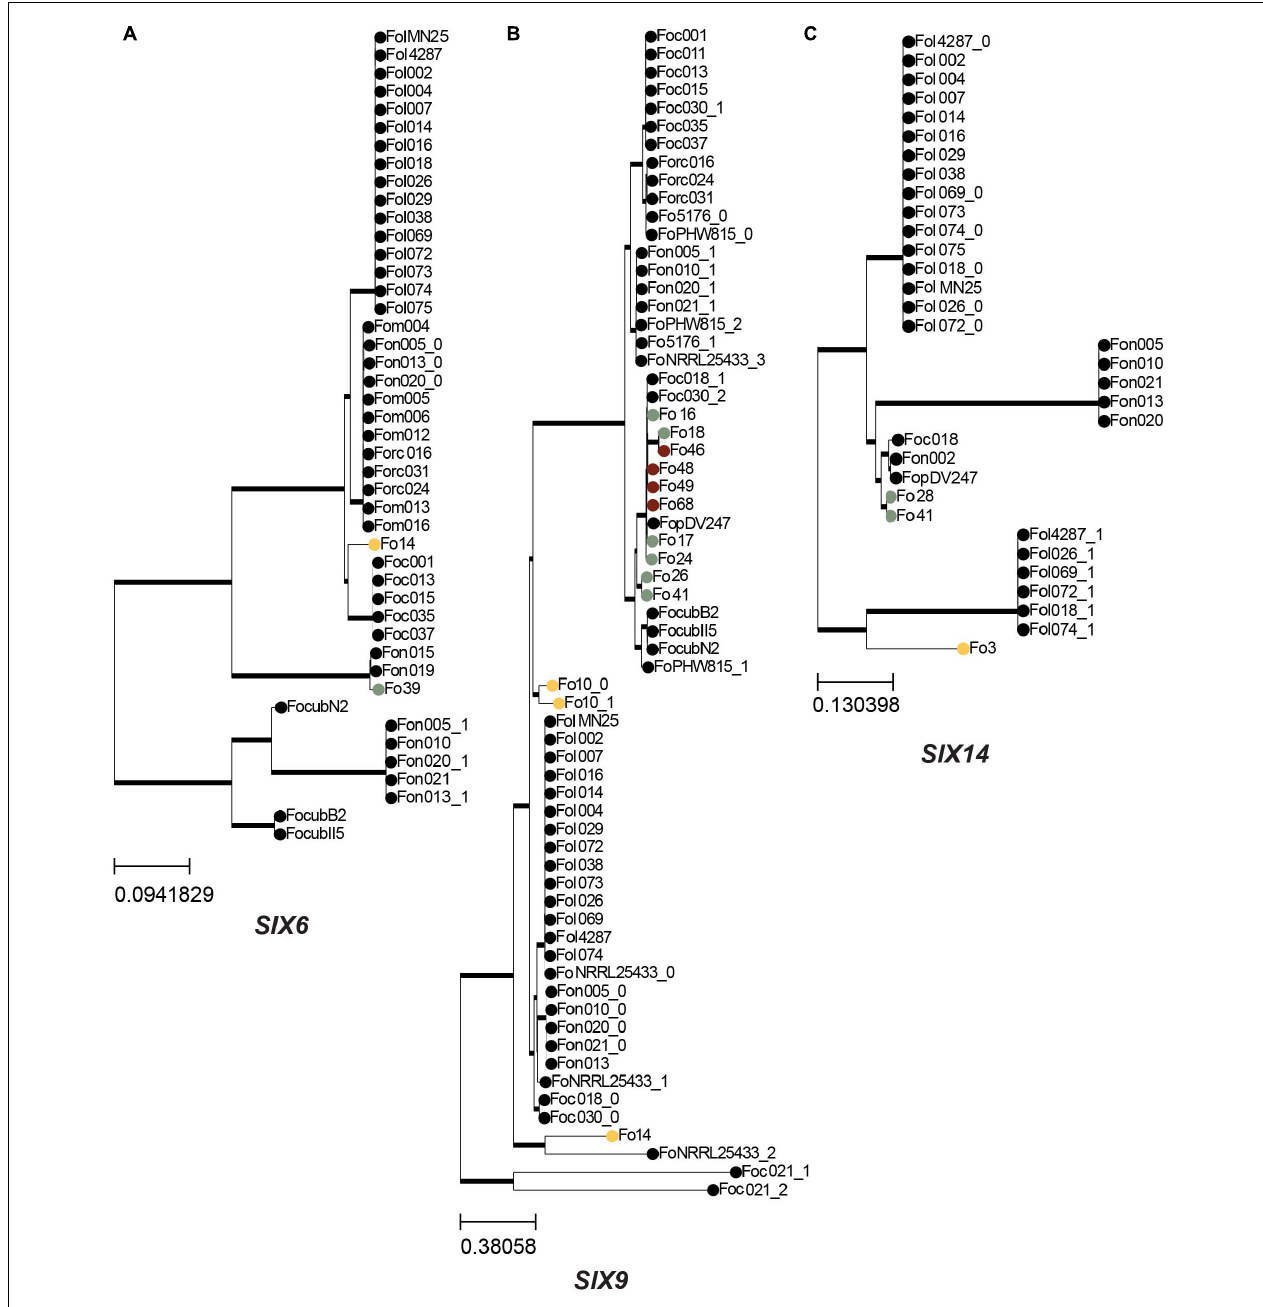
FIGURE 7 | SIX genes are generally vertically inherited in endophytic isolates. A maximum-likelihood phylogeny was inferred based on a multiple sequence alignment of the nucleotide sequences of SIX genes that are present in endophytes. Trees were rooted with midpoint rooting, thick lines indicate branches with 100% bootstrap support, colored circles indicate endophytes sequenced in this study, following the same color scheme as in Figure 1 : yellow – Australia; green – Spain; maroon – United States, other Fo isolates are shown as dots. (A) Phylogeny for SIX6 . (B) Phylogeny for SIX9 . (C) Phylogeny for SIX14